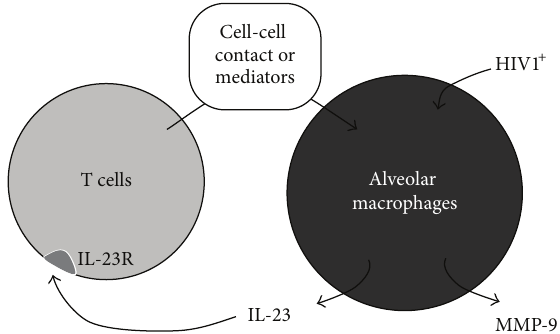
Figure 7: Proposed mechanism of IL-23 induced upregulation of AM MMP-9. IL-23 induced production of MMP-9 is indirect and requires the presence of non-AM cells such as T cells (“T”) in the alveolar environment. Memory T cells may express IL-23R and are known to be the target of IL-23. Upon stimulation with IL-23, T cells further induce the upregulation of MMP-9 in AM by a mechanism that likely requires direct cell-to-cell contact between T cells and